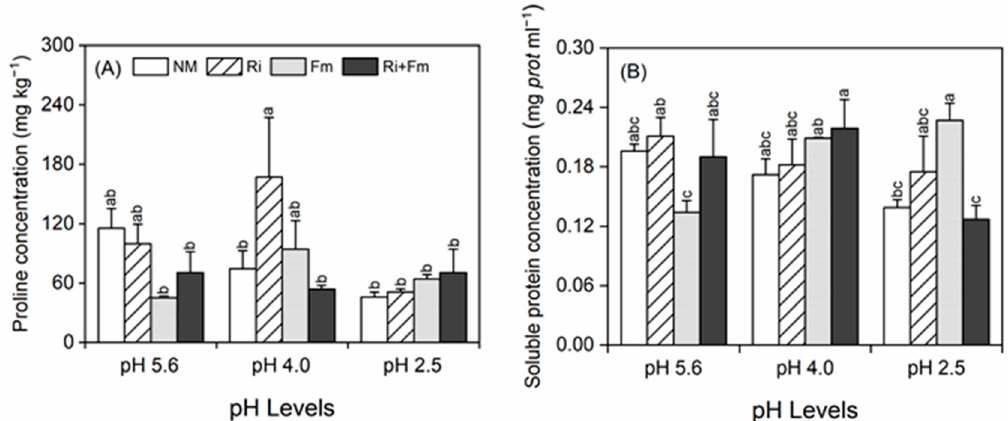
Figure 2. Effects of arbuscular mycorrhizal fungi on total dry weight ( A ) and root:shoot ratio ( B ) of Torreya grandis under acid rain with pH 5.6, 4.0, and 2.5. NM, Ri, Fm, and Ri+Fm represent the four AMF treatments: inoculation with no mycorrhizal fungi, with Rhizophagus irregularis , with Funneliformis mosseae , and with the combination of the two fungi inoculum, respectively. Values are presented as the mean ± SE ( n = 6). Different letters indicate a significant difference ( p < 0.05).